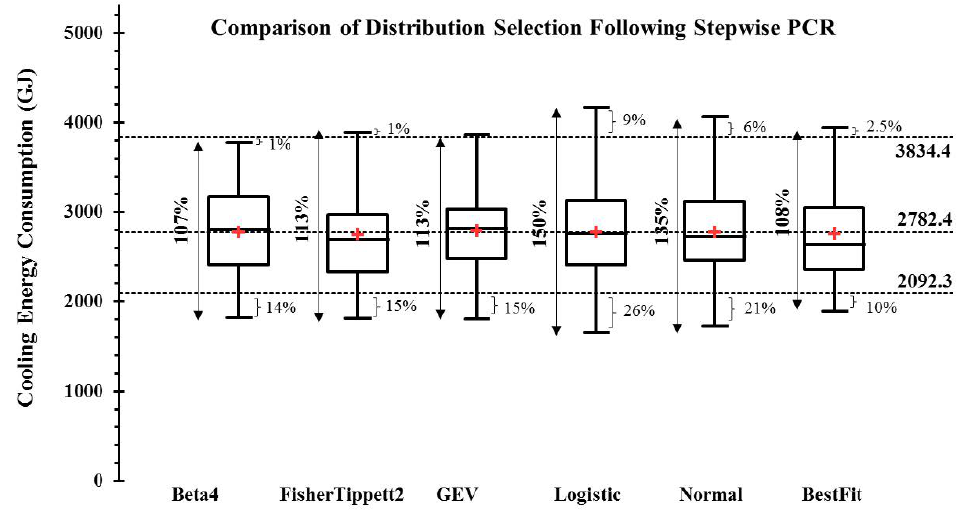
Figure 14. Cooling energy use probability density functions when following a Stepwise Principal Component Regression model and comparing selection of various input principal component distribution series used in the uncertainty propagation